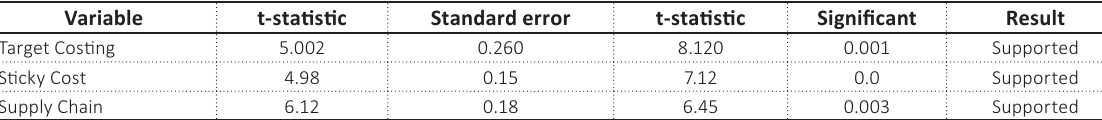
Table 3. Multiple regression